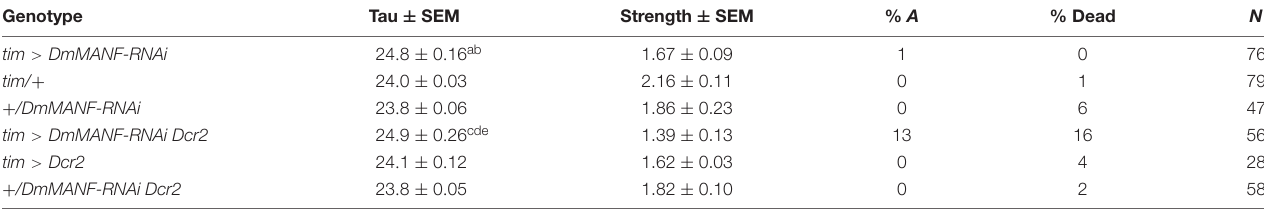
TABLE 1 | Period (tau) and strength of the rhythm under DD in flies subjected to downregulation of DmMANF in clock cells. Genotype Tau ± SEM Strength ± SEM % A % Dead N tim > DmMANF-RNAi 24 . 8 ± 0 . 16